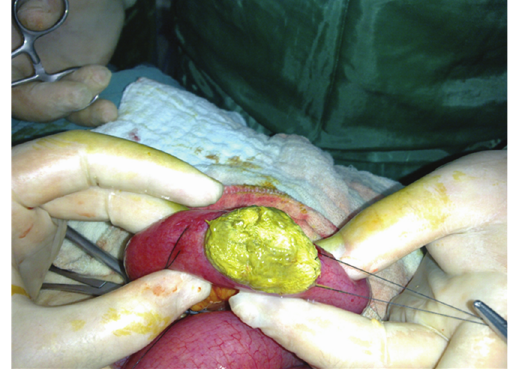
Figure 2: GP’s appearance in an enterotomy-applied ileum during operation.